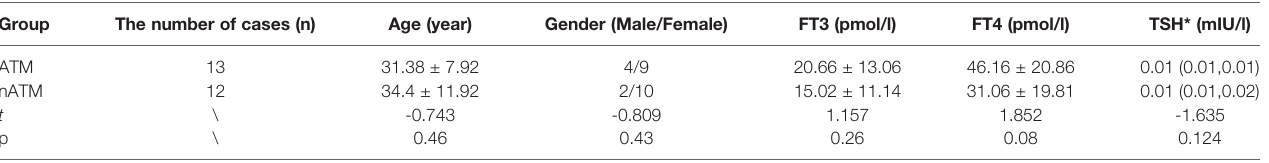
TABLE 1 | Comparison of basic information and clinical data between the two groups of patients. Group